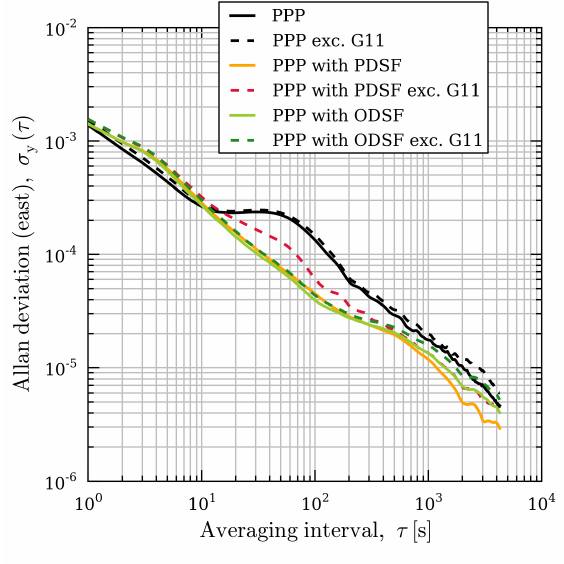
Figure 4: Allan deviation plots of the corresponding easting position time series at station UEL between 15:17 and 21:04 on August 31 2013 shown in Fig. 3.